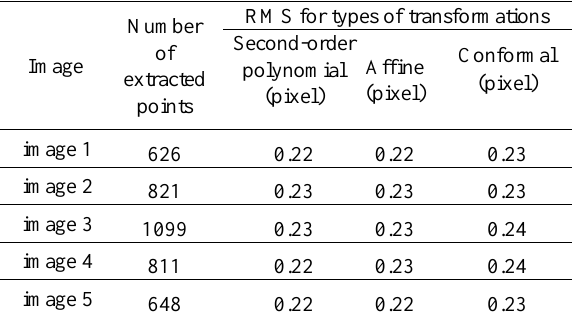
Table 2. RMS for types of transformations.